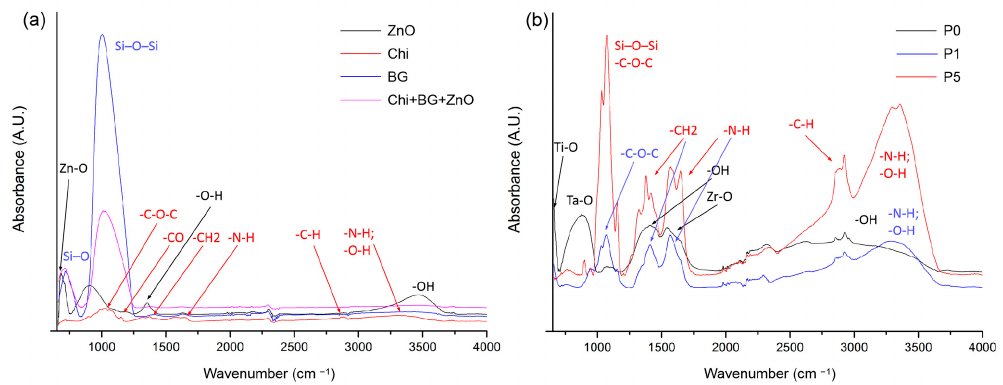
Figure 6. FT-IR spectra obtained for ( a ) mixture components; ( b ) Ti-Zr-Ta-Ag samples.